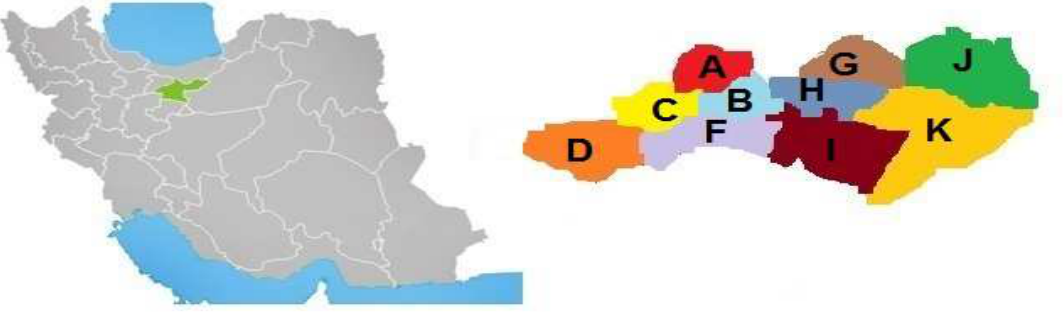
F IGURE 1. Collecting sites of Mantodea: Tehran province (green color) within Iran (Left); the districts (Right) (for localities and details see Table